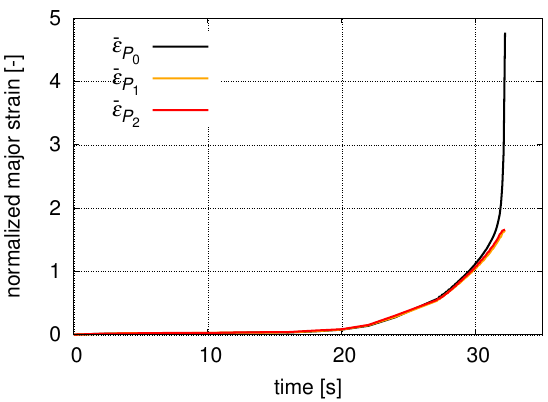
Figure 13. Growth of the major strains (normalized with respect to the mean uniform strain) in a sample in the necking and non-necking regime [33].